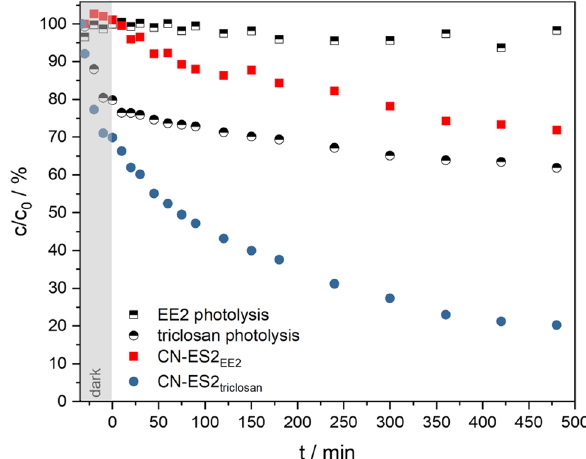
Fig. 8 Time-dependent photodegradation of aqueous ethinyl estradiol and triclosan solutions (4 × 10 -5 M) under visible-light irra- diation (t > 0 min) without catalyst and in the presence of CN-ES2 as photocatalytic